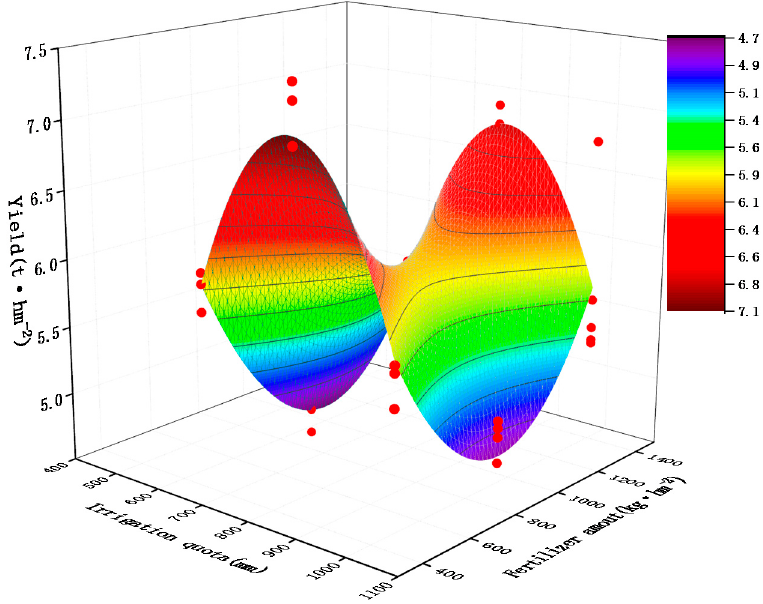
Figure 5. Water–fertilizer optimization based on maximum jujube yield.